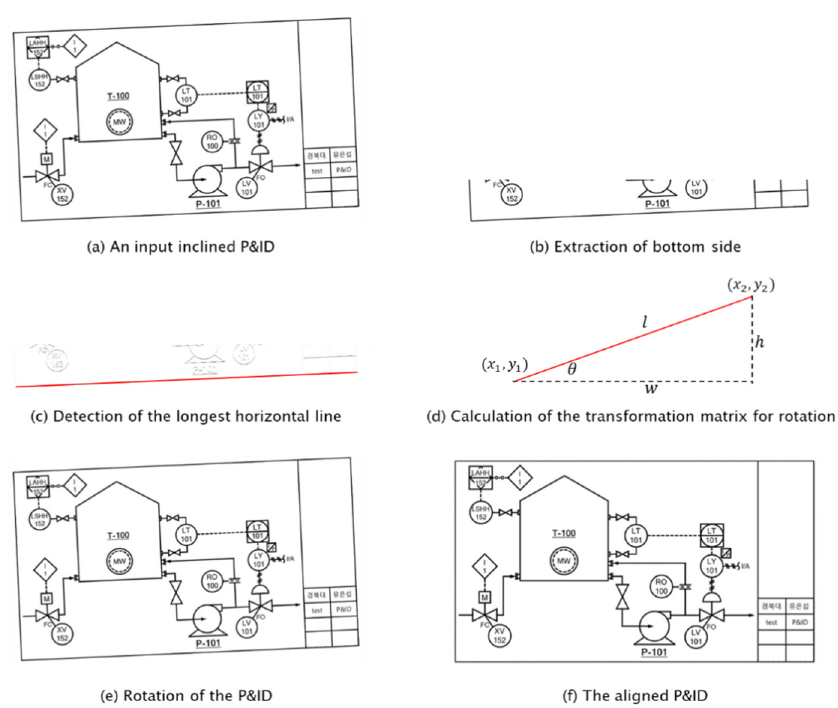
Figure 2. Alignment of an inclined P&ID.